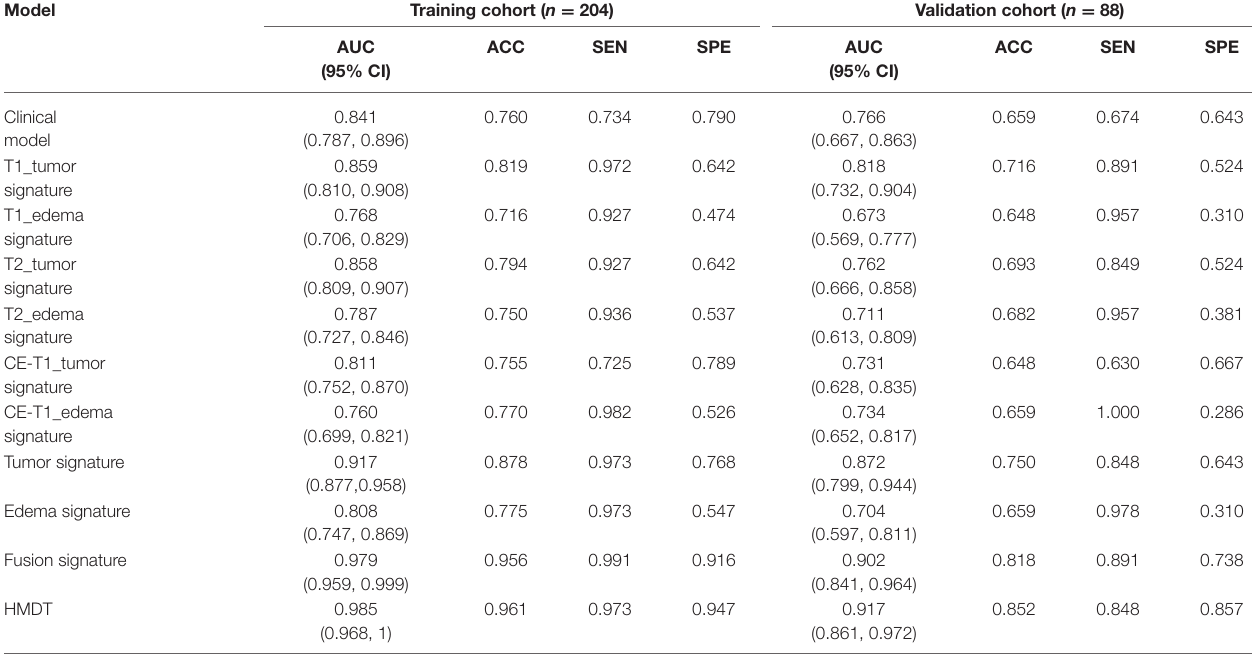
TABLE 2 | Diagnostic ability of the developed